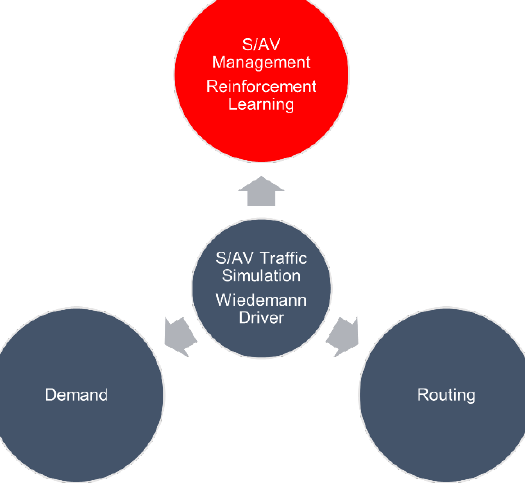
Figure 5. Extension Package Library written in Python [35].